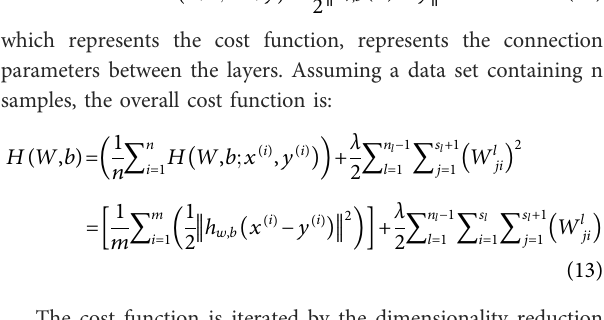
FIGURE 3 Sensitivity, speci fi city and diagnostic coincidence rate of MR staging.